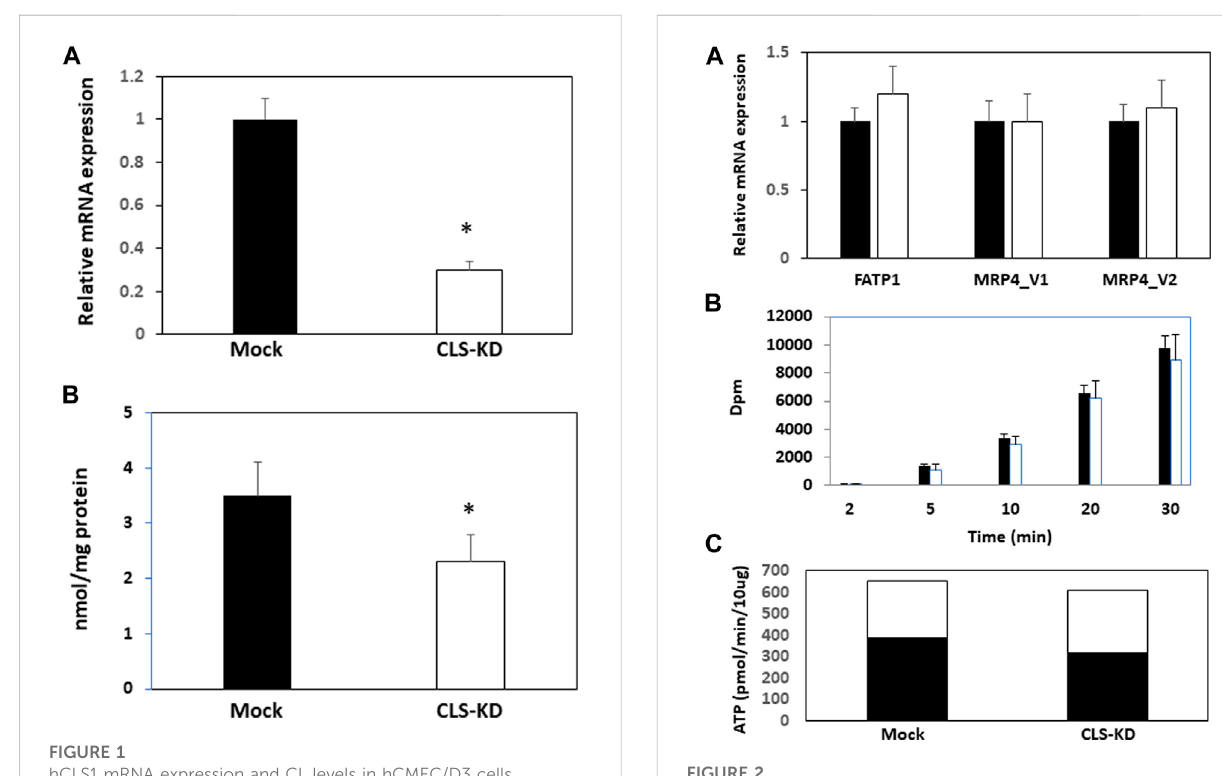
FIGURE 2 Expression of FATP1, MRP4_v1, and MRP4_v2, (1 – 14 C)oleate uptake and relative contribution of oxidative phosphorylation and glycolysis to ATP production in hCMEC/D3 cells transfected with hCLS1 siRNA. hCMEC/D3 cells were mock transfected (closed bars) or transfected with hCLS1 siRNA (open bars) for 48 h and FATP1, MRP4_v1, and MRP4_v2 mRNA expression (A) , and (1 – 14 C)oleate uptake (B) determined. (C) . Relative contribution of oxidative phosphorylation (closed bars) and glycolysis (open bars) to ATP production was determined as described in Materials and Methods. n = 3 − 4, * p <